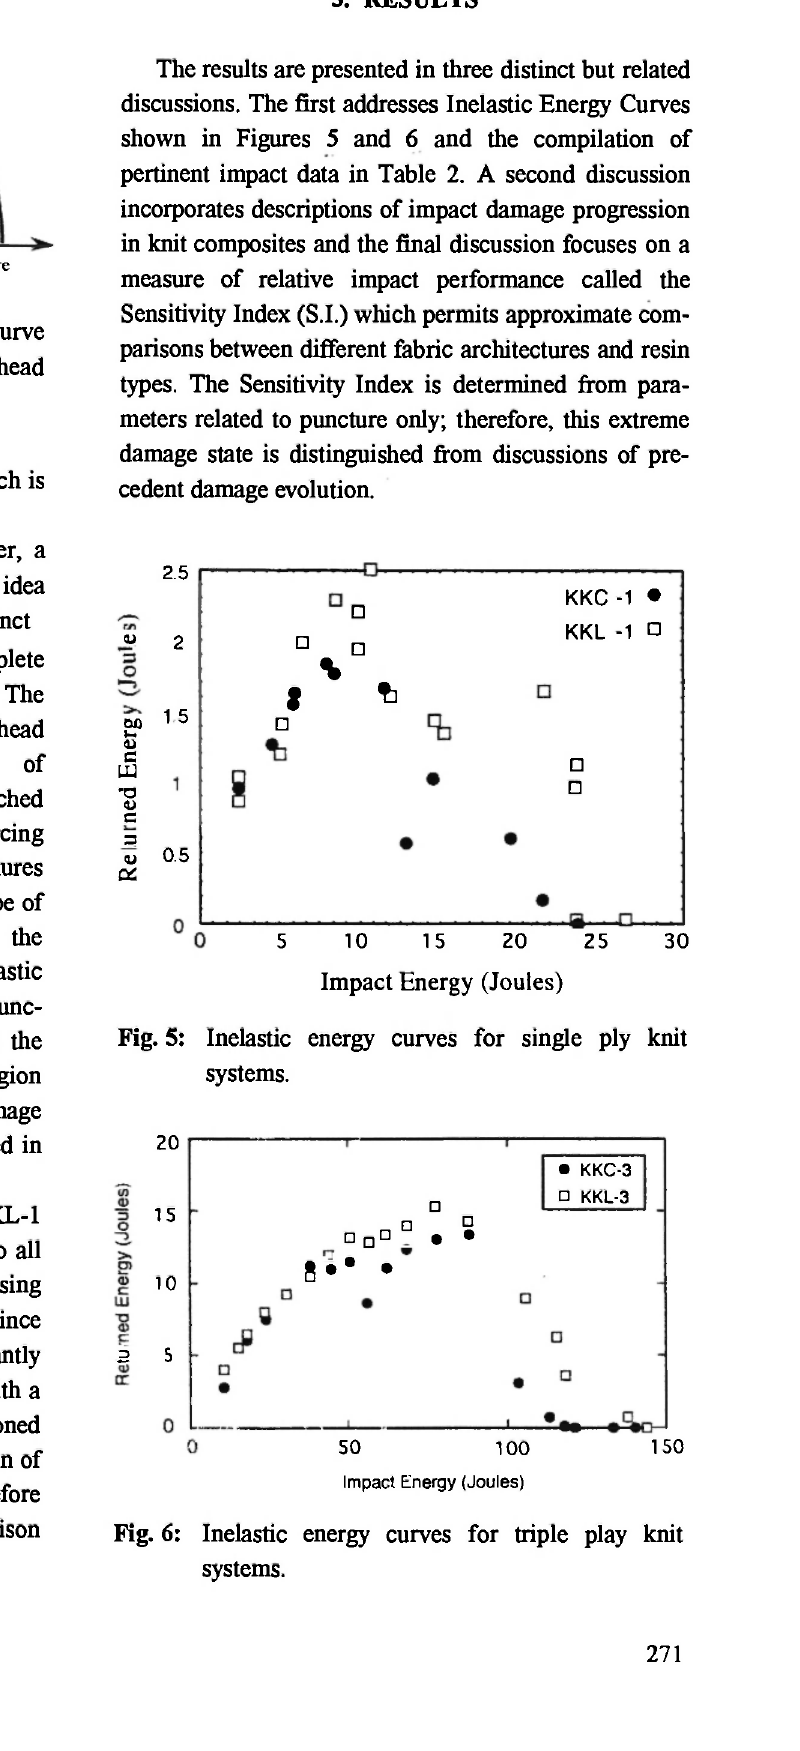
Fig. 4: General form of the inelastic energy curve presented for a condition of constant crosshead mass.